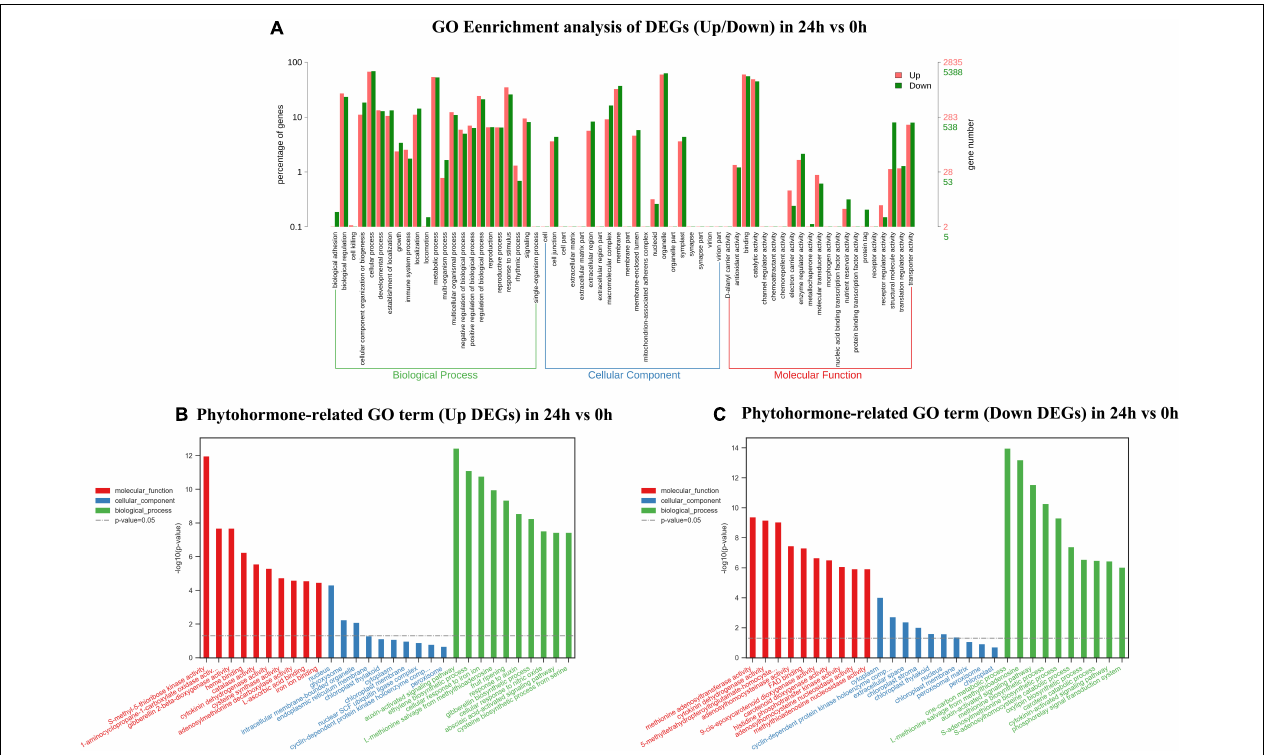
FIGURE 4 | Gene ontology enrichment analysis of up/down DEGs (A) , phytohormone-related GO terms (up DEGs) (B) , and phytohormone-related GO terms (down DEGs) (C) in 24 vs. 0